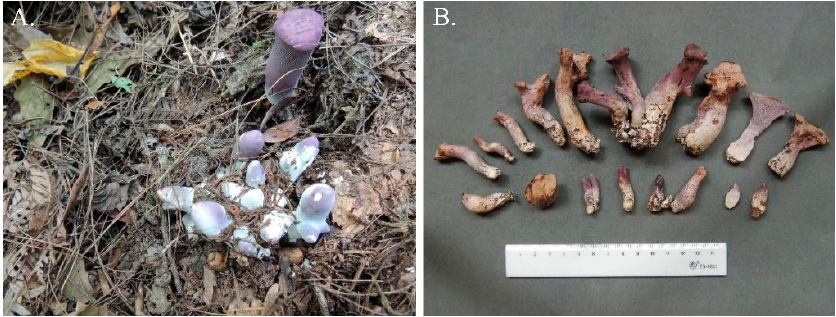
Figure 1. Fruiting bodies of G. purpuraceus . ( A ) Habitat. ( B ) Basidiomata. The genus Gomphus is classified as a part of the ectomycorrhizal (ECM) fungal line- age/ramaria-gautieria [18]. According to the existing ecological survey, G.